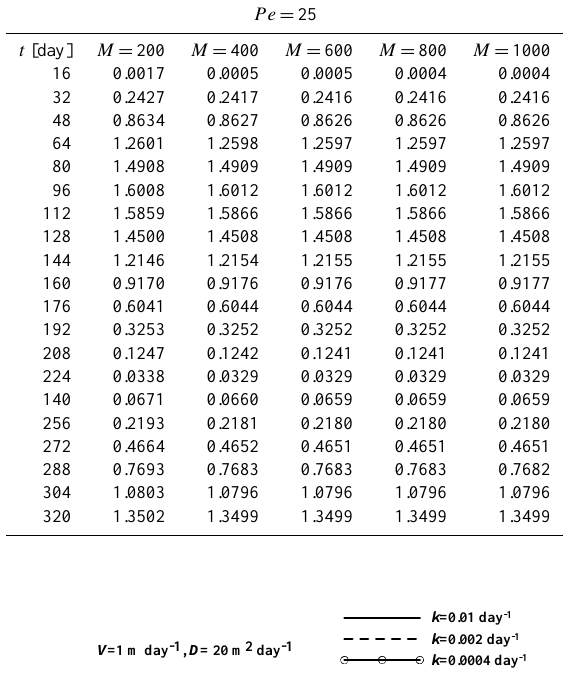
Table 3. Solution convergence for sinusoidal periodic function (1 + sin t) ( M is number of terms summed).